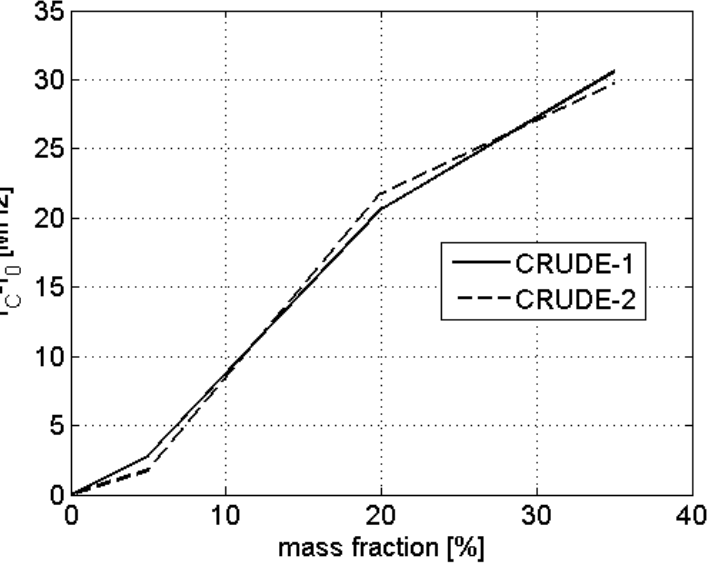
Figure 9. Evolution of the resonant frequency difference f 0, C − f 0 with the mass fraction of salt-water for mixtures created from two different samples: CRUDE-1 (solid) and CRUDE-2